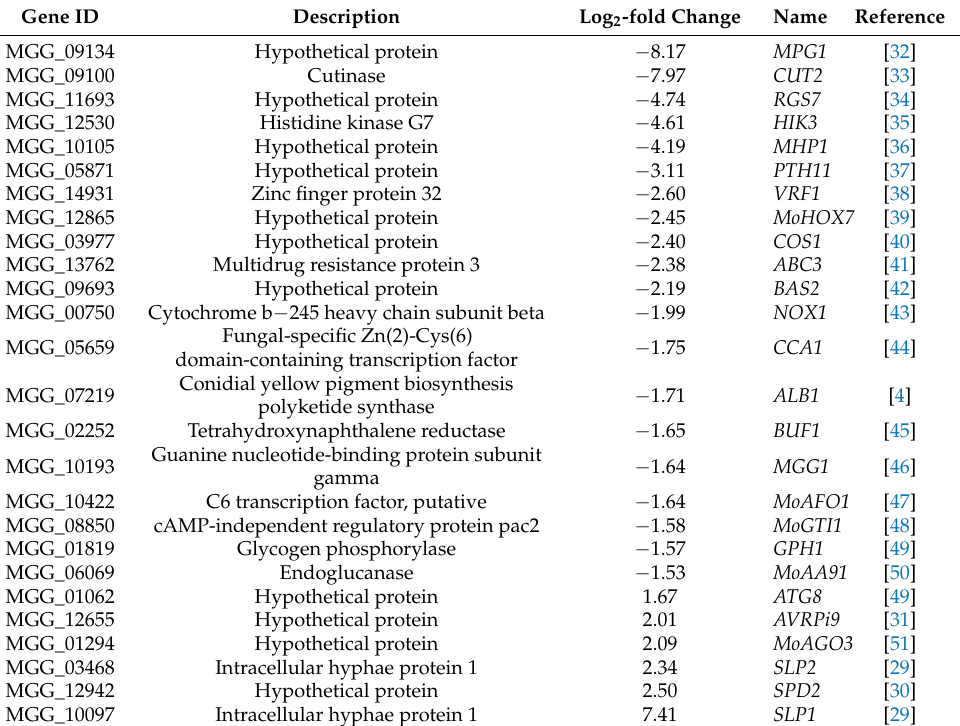
Table 1. Differentially expressed genes related to pathogenesis in the ∆ moade12 mutant using |log 2 FC| > 1.5 and a q -value <